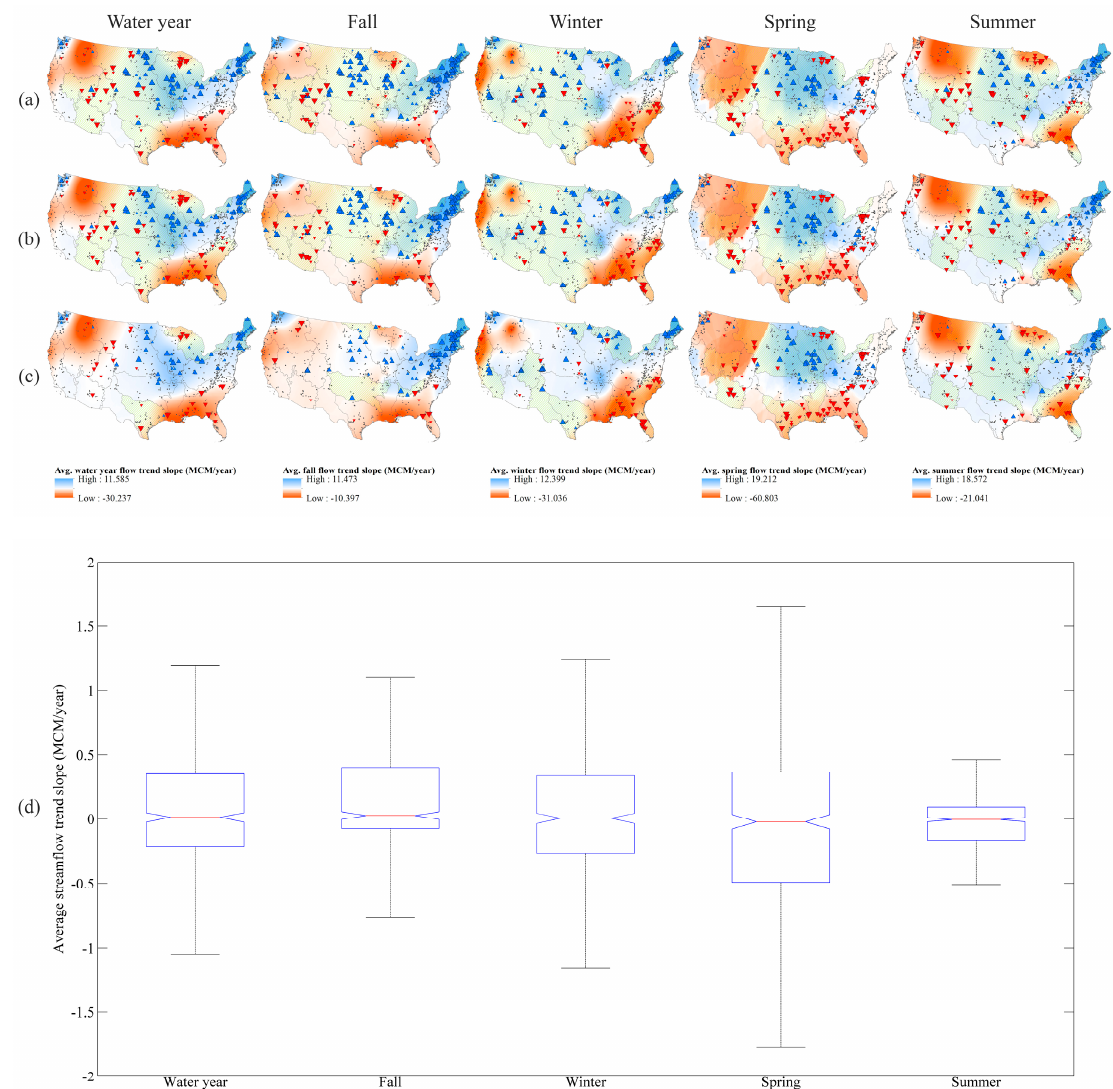
Figure 2. Spatial distribution of the stations with trends across the continental U.S. under ( a ) MK1; ( b ) MK2; and ( c ) MK3 in water-year and the four seasons ( i.e. , fall, winter, spring and summer). Significant increasing (decreasing) trends are shown by the upward (downward) pointing blue (red) triangles, respectively. The three different sizes of triangles (small, medium, and large) correspond to the confidence levels of 90%, 95%, and 99%, respectively. Dots indicate no significant trend. Hatched regions (light green) show the presence of field significance; ( d ) distribution of average streamflow trend slope (MCM/year) in water year and the four seasons. The box plots show the distribution after removal of the